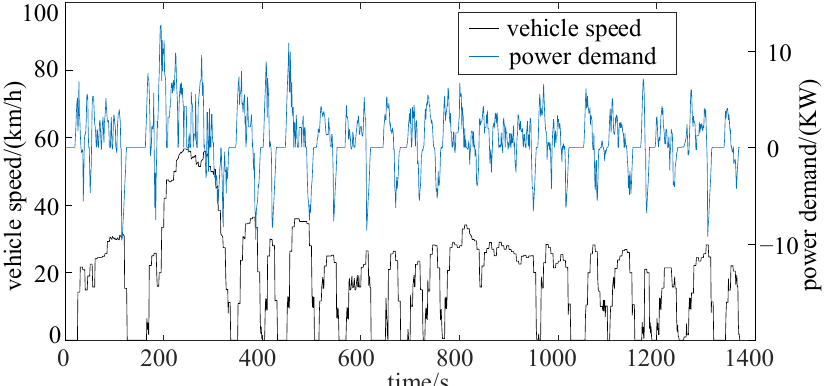
Figure 18. Vehicle speed and power demand of UDDS cycle.